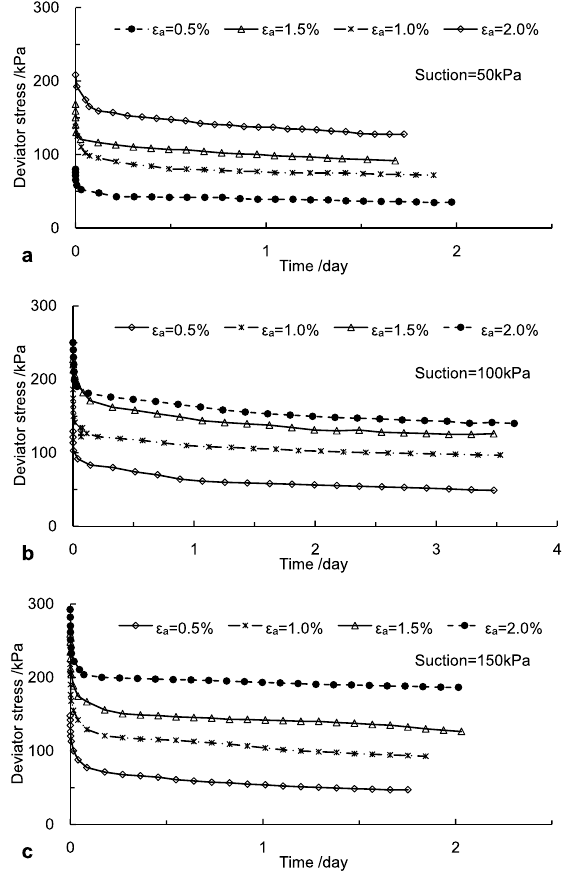
Figure 5. The processed stress relaxation curves: ( a) suction = 50 kPa, ( b) suction = 100 kPa and ( c) suction = 150